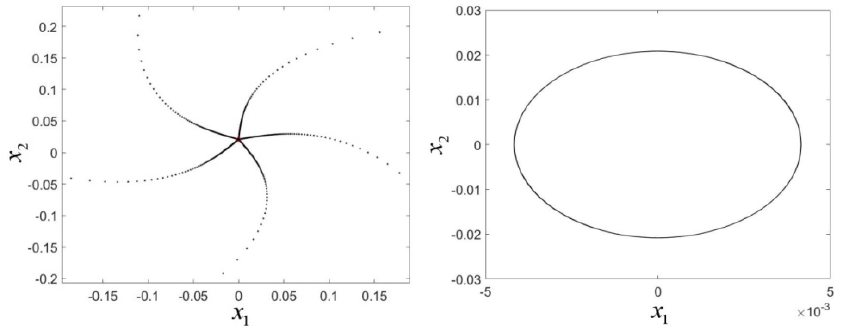
Figure 6. The stable periodic motion in 1:5 resonance when µ = − 0.01: ( left ) the stable fixed point; ( right ) the stable periodic motion.